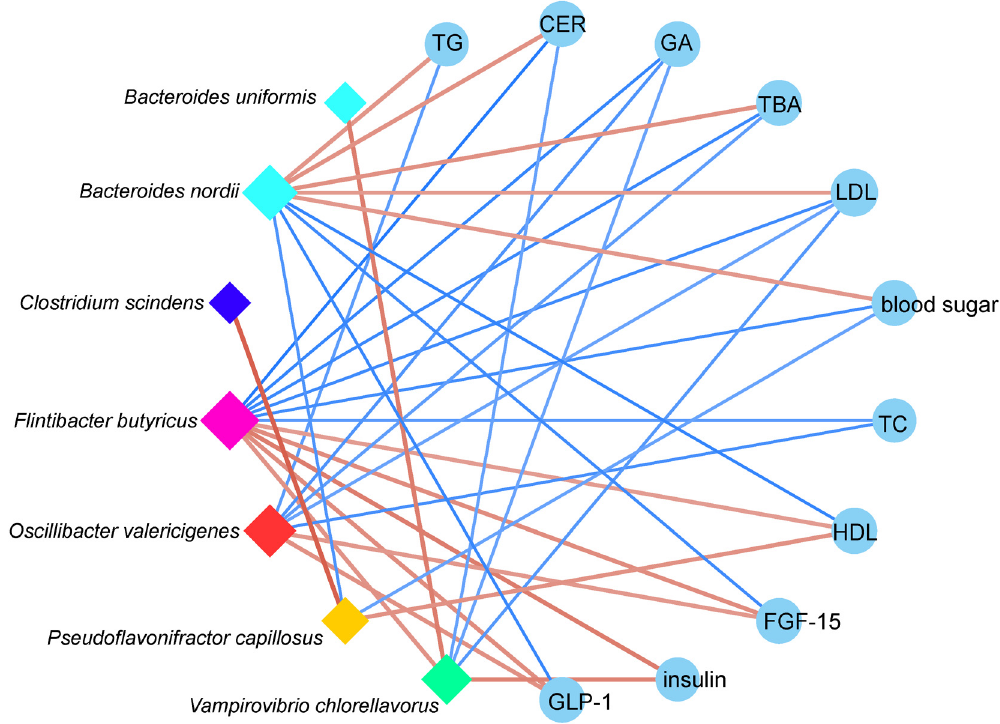
Figure 4: The correlation between indicators such as blood glucose metabolism, blood lipids, and di ff erent species. Red represents positive correlation, blue represents negative correlation, and the thickness of the line represents the strength of the